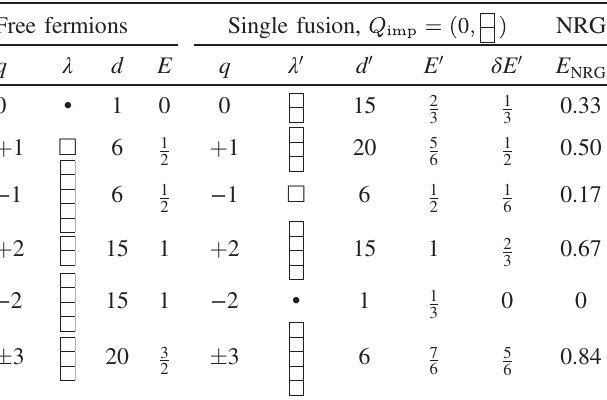
particles into six available states.